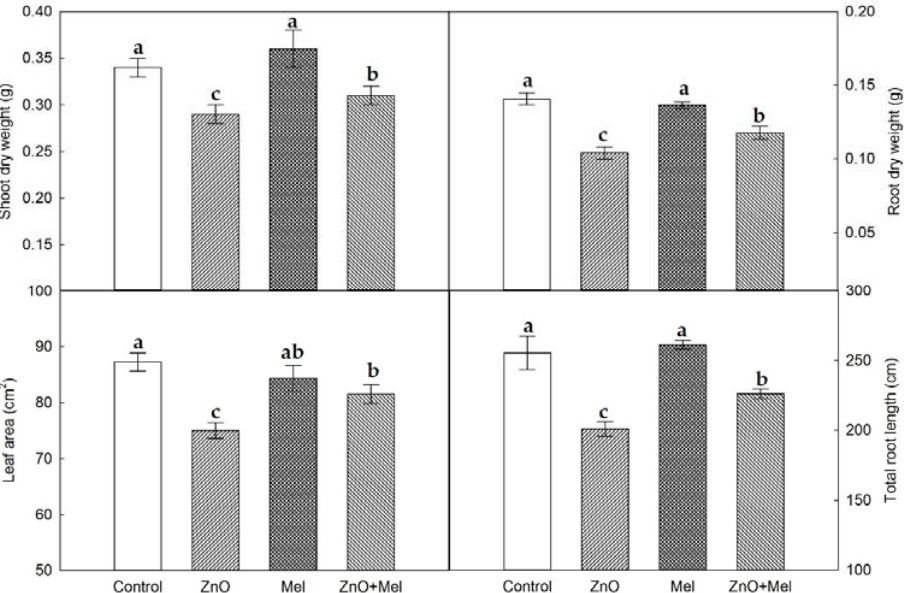
Figure 1. Plant growth parameters in wheat as affected by melatonin application and Zinc Oxide (ZnO) nanoparticles. Mel, melatonin. Data represent the mean ± SE of three replicates. Different letters indicate significant differences ( p < 0.05).